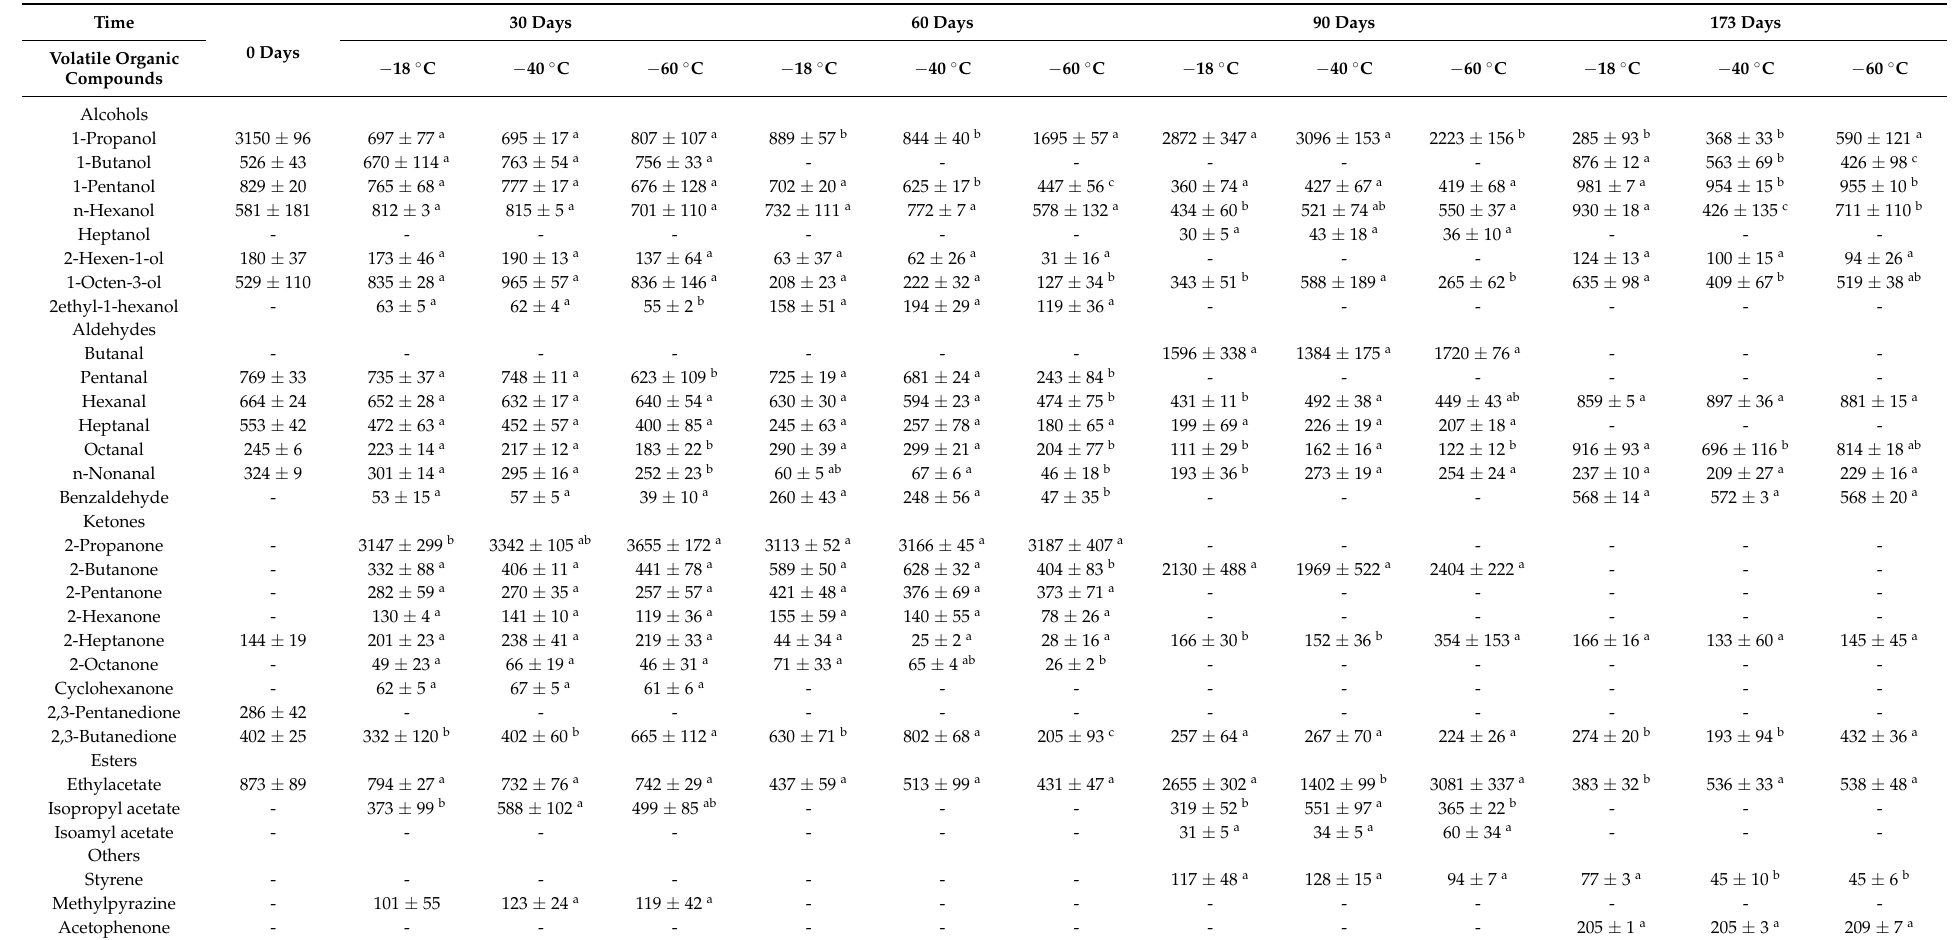
Table 1. Effects of different freezing storage temperatures on volatile organic compounds in snowflake beef ( n = 4); abc represents significant differences of different freezing temperatures for the same storage